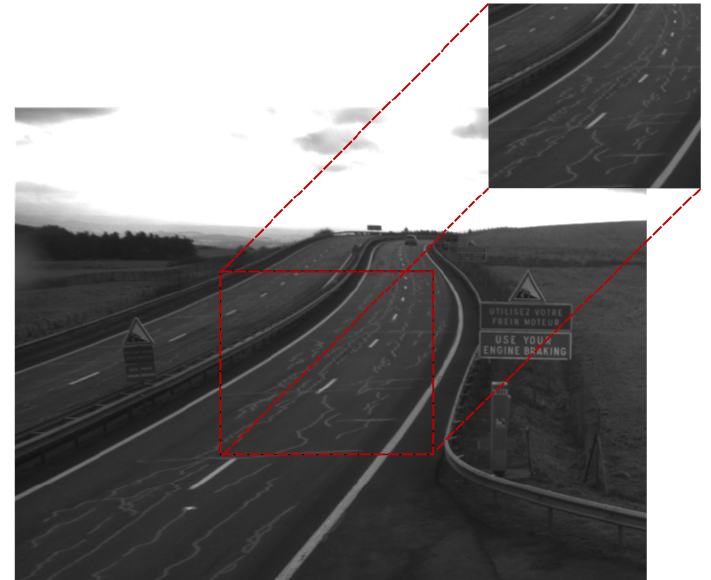
Figure 3. Example of fixed scene extracted from an image center, which belongs to the Cerema- AWH